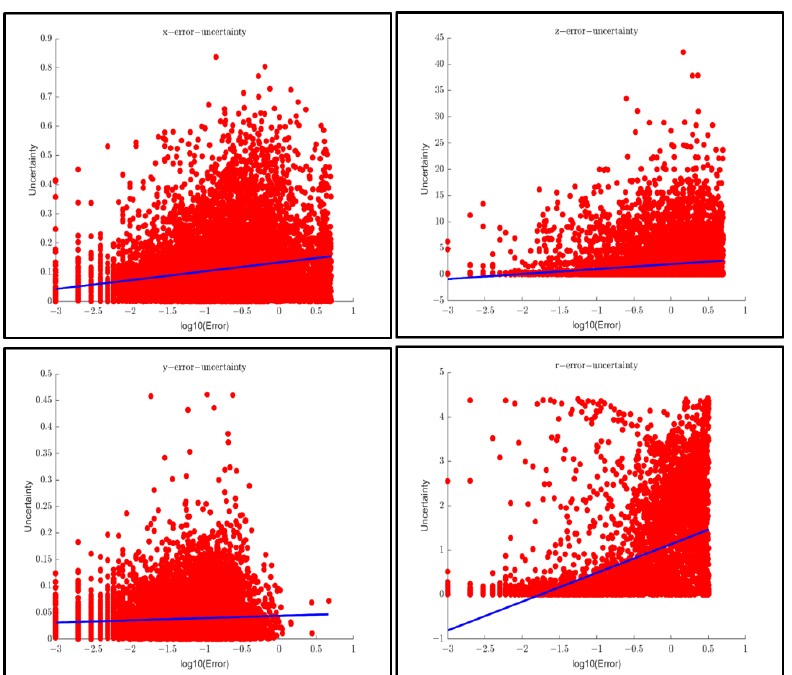
Figure 14. Correlation research between uncertainty and error of SMOKE (3769 frames) In order: the horizontal direction, longitudinal direction, vertical direction, and orientation of the